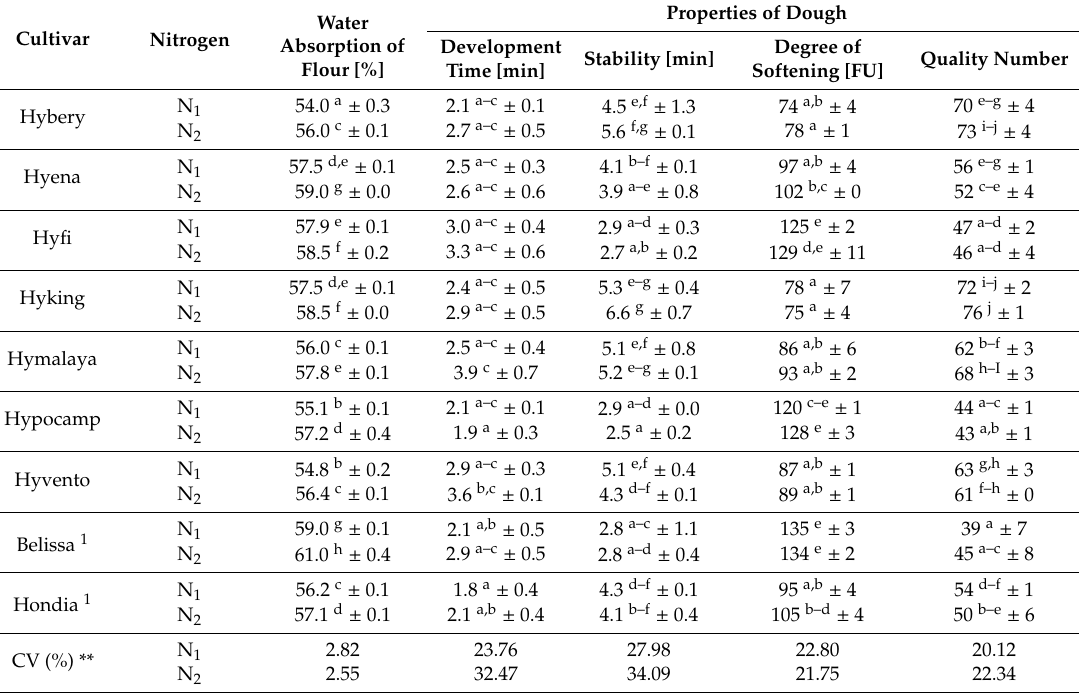
Table 3. Results of rheological analysis of wheat flour obtained from hybrid and population cultivars.